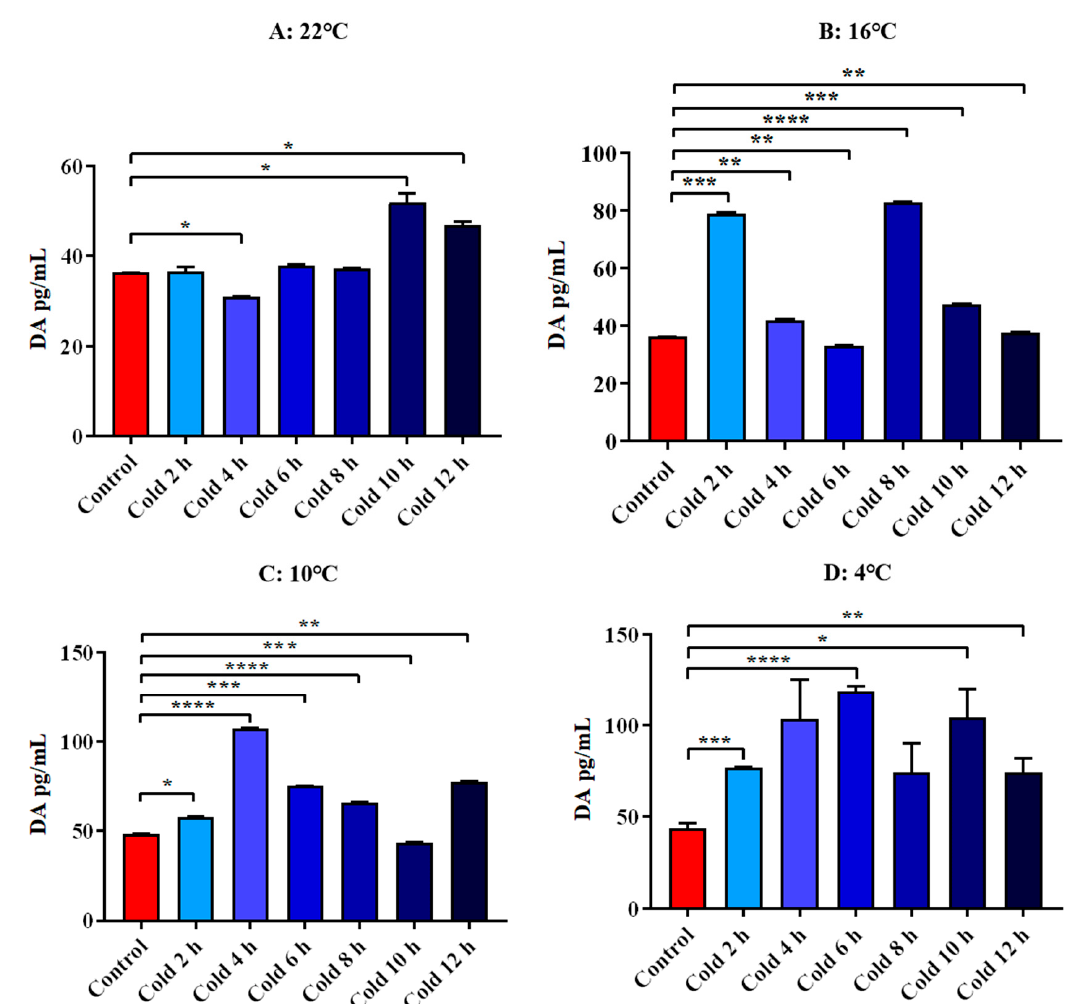
Figure 13. Changes of serum DA of ICR mice under different intensity of cold exposure. ( A ). Changes in the serum DA of mice under cold exposure at 22 ◦ C; ( B ). Changes in serum DA of mice under cold exposure at 16 ◦ C; ( C ). Changes in the serum DA of mice under cold exposure at 10 ◦ C; ( D ). Change in the serum DA of mice under cold exposure at 4 ◦ C. Compared with 28 ◦ C normal temperature control group, the difference was significant as * p < 0.05. ** p < 0.01. *** p < 0.001. **** p < 0.0001.